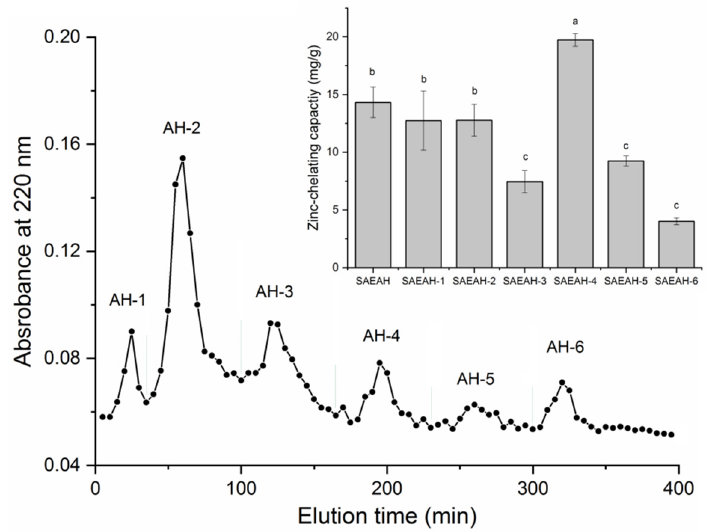
Figure 1. The separation profiles of sweet almond expeller amandin hydrolysates (SAEAH) on Sephadex G-15 gel chromatography and zinc-chelating capacities of subfractions AH-1, AH-2, AH-3, AH-4, AH-5 and AH-6. Lowercase letters ( a – c ) above the bars and in the table denote significant difference ( p < 0.05).